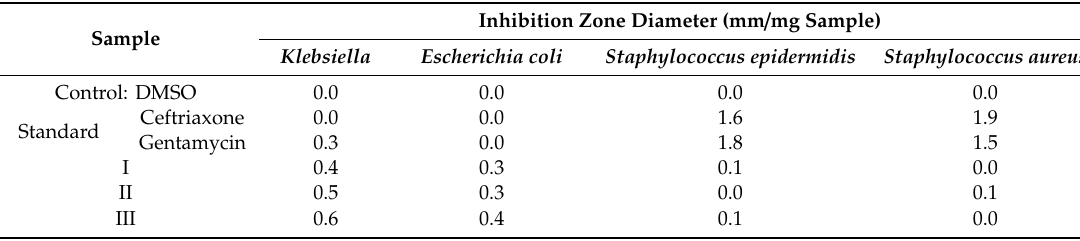
Table 8. Inhibition zone diameter of Ru(III) OFL complexes I–III against four bacterial